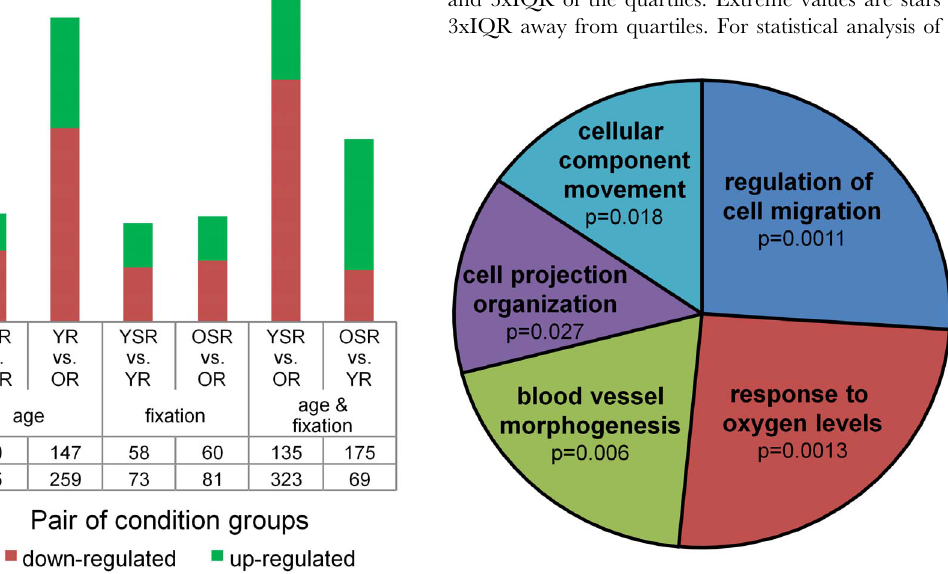
Figure 2. Number of differentially expressed genes for each pair of condition groups. With Affymetrix Transcriptome Analysis Console (TAC) a traditional unpaired One-Way Analysis of Variance (ANOVA) for each pair of condition groups was performed (Linear Fold Change ,2 2 or . 2; ANOVA p-value (condition pair) , 0.05).